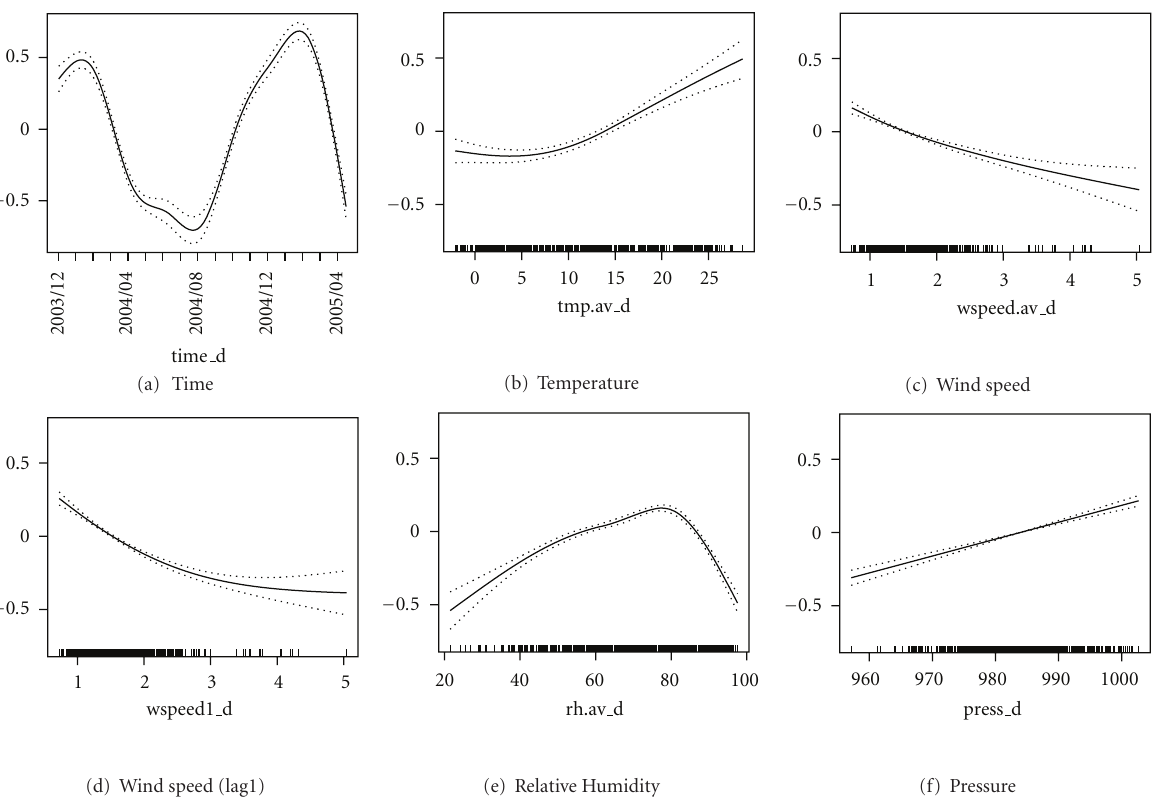
Figure 9: Estimated e ff ects of meteorological variables for PM 10